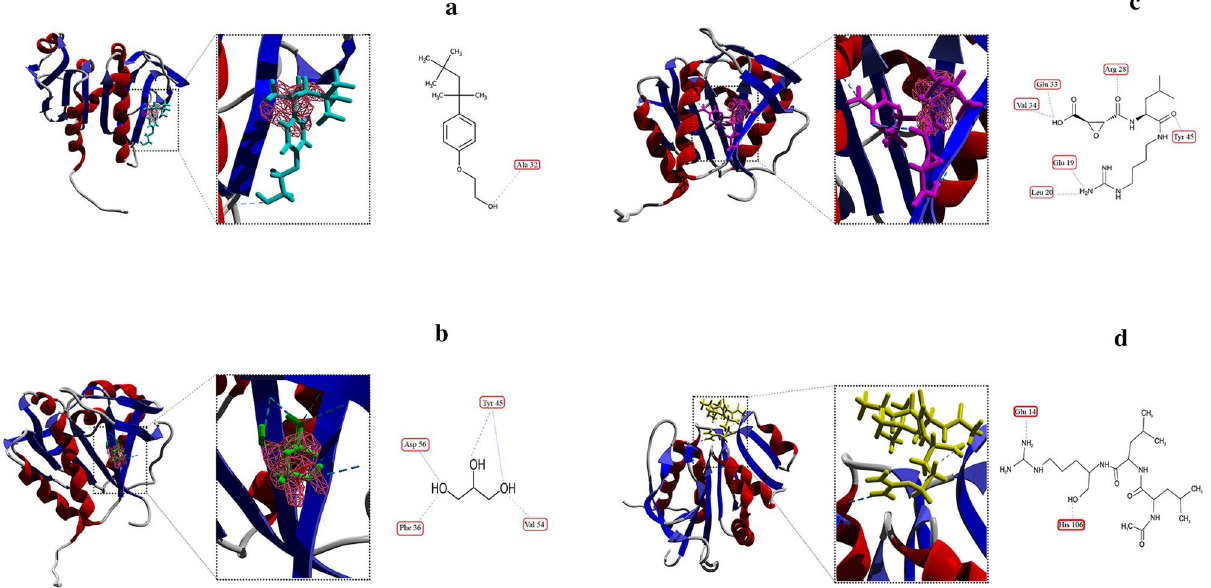
Figure 5. ( a ) Docking of rEla and Triton x-100. Triton x-100 is a surfactant with an increasing impact on protease activity. 2D display shows interaction between Ala 32 of rEla with oxygen atom of Triton x-100. ( b ) Docking of glycerol as a ligand and rEla. Glycerol interacts with allosteric cavity via 5 hydrogen bonds as 2D structure represents. Molecular docking of two cysteine protease specific inhibitors E.64 ( c ) and Leupeptin ( d ). E.64 seems to inhibit the enzyme by 6 hydrogen bond interactions with allosteric cavity and changing the protease active conformation. Unlike E.64, Leupeptin is a competitive inhibitor which interacts with active site via 2 hydrogen bonds with His-106 and